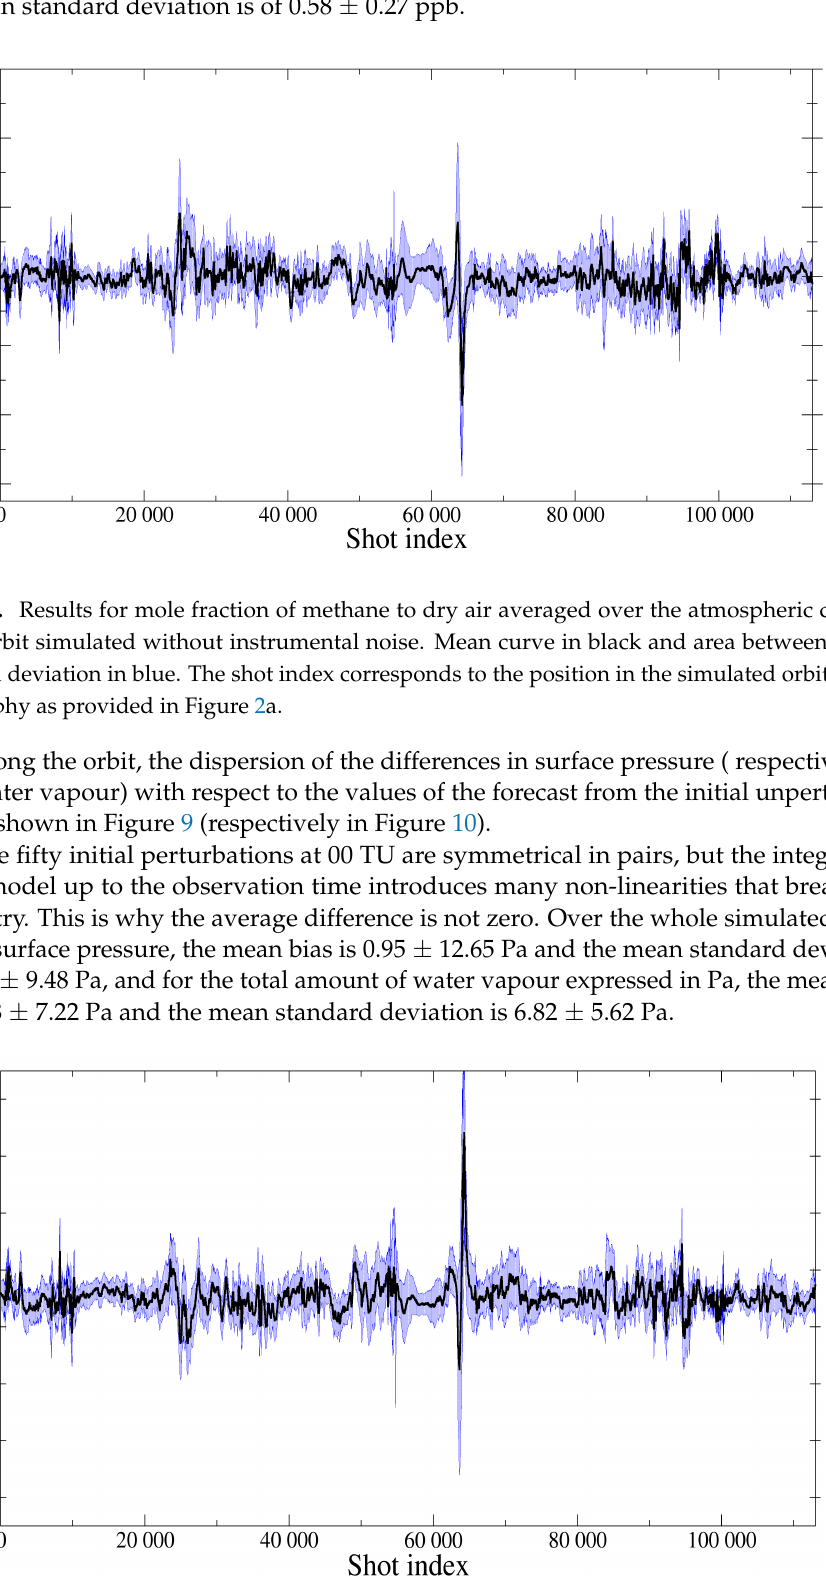
Figure 9. Discrepancies on the surface pressure. Mean curve in black and area between ± one standard deviation in